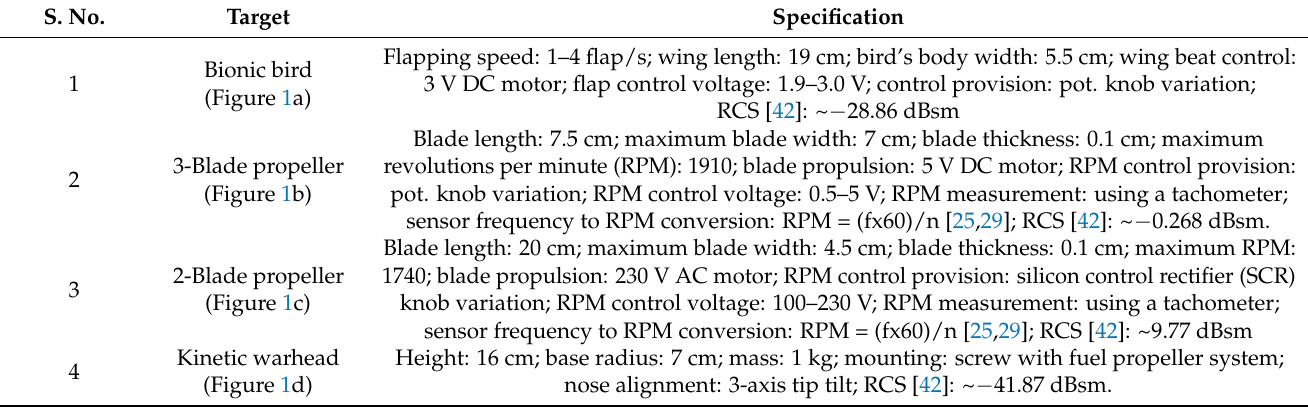
Table 1. Specifications of the low RCS flapping/rotational/motional targets used in this